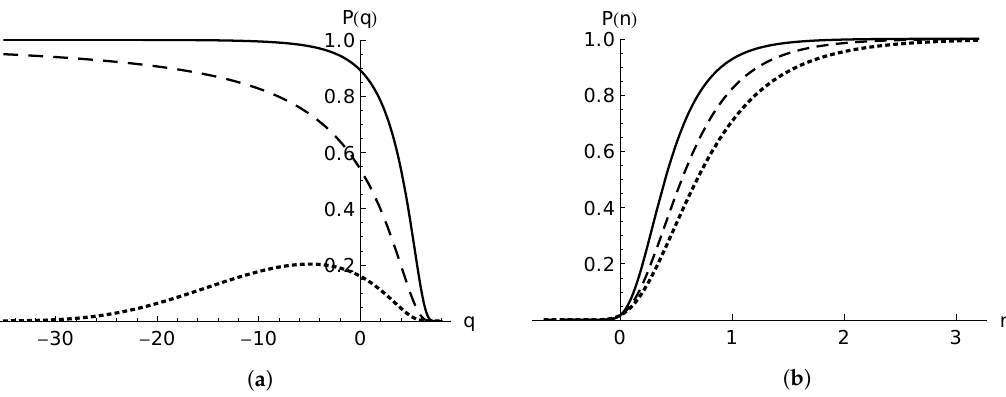
Figure 1. ( a ) The tunneling probability (36) for the varying G model ( k = + 1, n = 2, Λ = 2); ( b ) The tunneling probability (36) for varying c model ( k = + 1, q = 0, Λ = 5). The solid lines are for dust (w = 0), the dashed lines are for radiation (w =1/3), and the dotted ones are for stiff-fluid (w= 1)